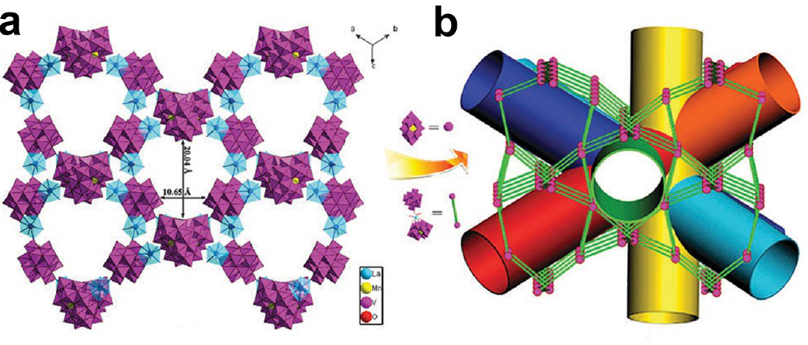
Figure 12. ( a ) Polyhedral representation for the frameworks constructed by lanthanide ion and [MnV 13 O 38 ] 7 − polyoxoanion in compounds H[La(H 2 O) 4 ] 2 [MnV 13 O 38 ]·9NMP·17H 2 O and H[Ce(H 2 O) 4 ] 2 [MnV 13 O 38 ]·9NMP·17H 2 O; ( b ) The representation of the multi-directional channel system in the compounds. Reproduced with permission from RSC, 2014